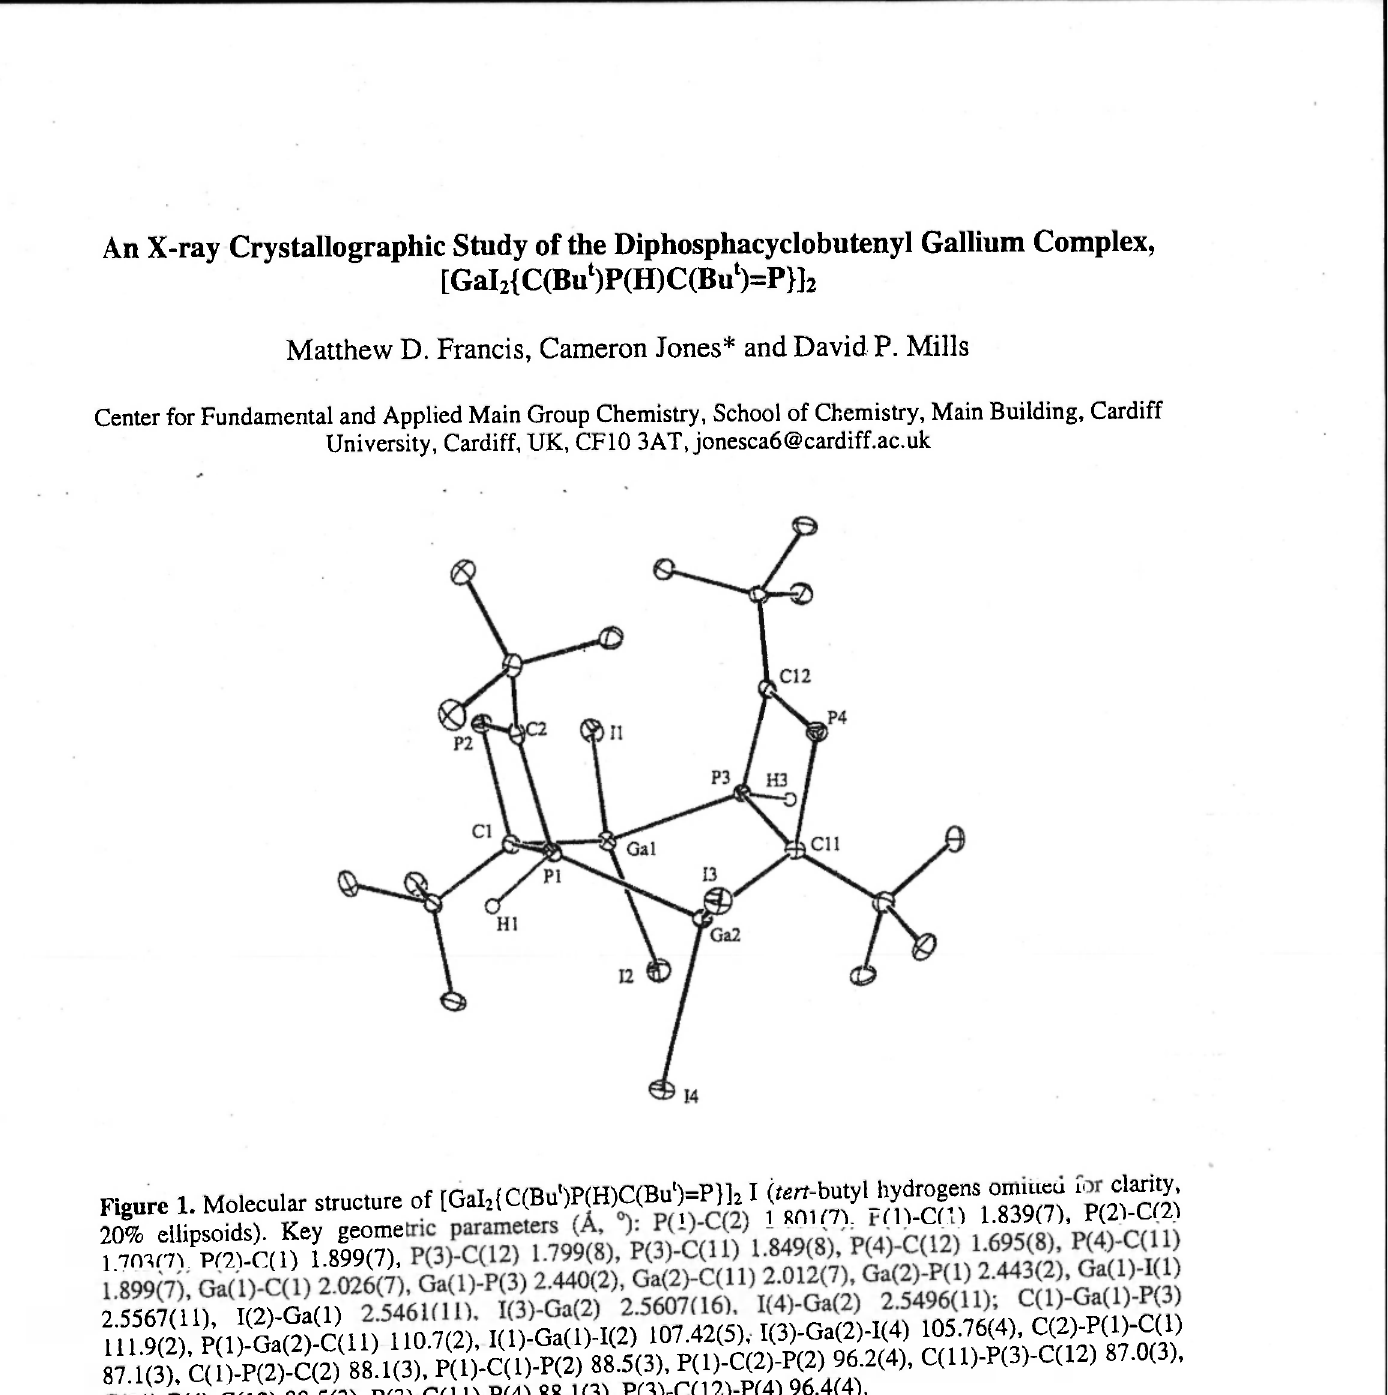
fbÄ.IÄ Figure 1. Molecular structure of (Gal^CiBuVmCfBu'j.Plh I S S s e s e s ss C(l l)-P(4)-C(12) 88.5(3), P(3)-C(ll)-P(4) 88.1(3), P(3)-C(12)-P(4)